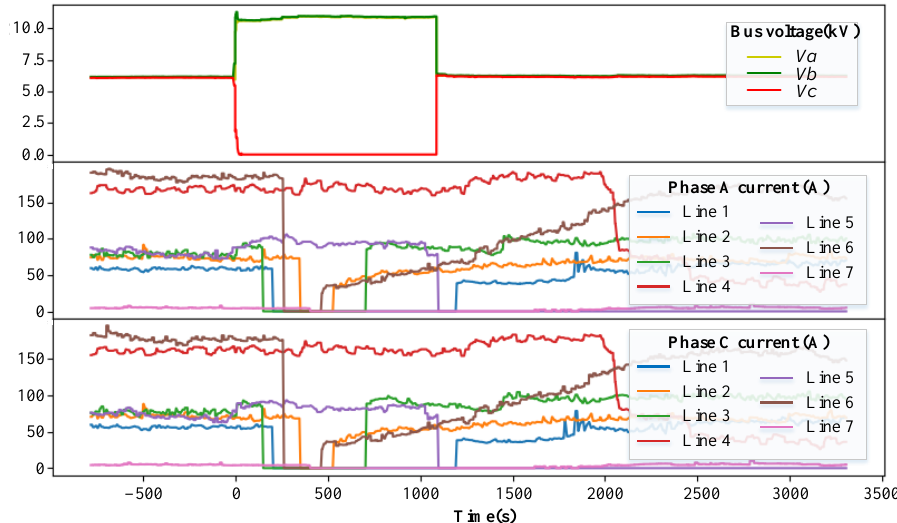
Figure 12. A single-phase grounding fault in system B.